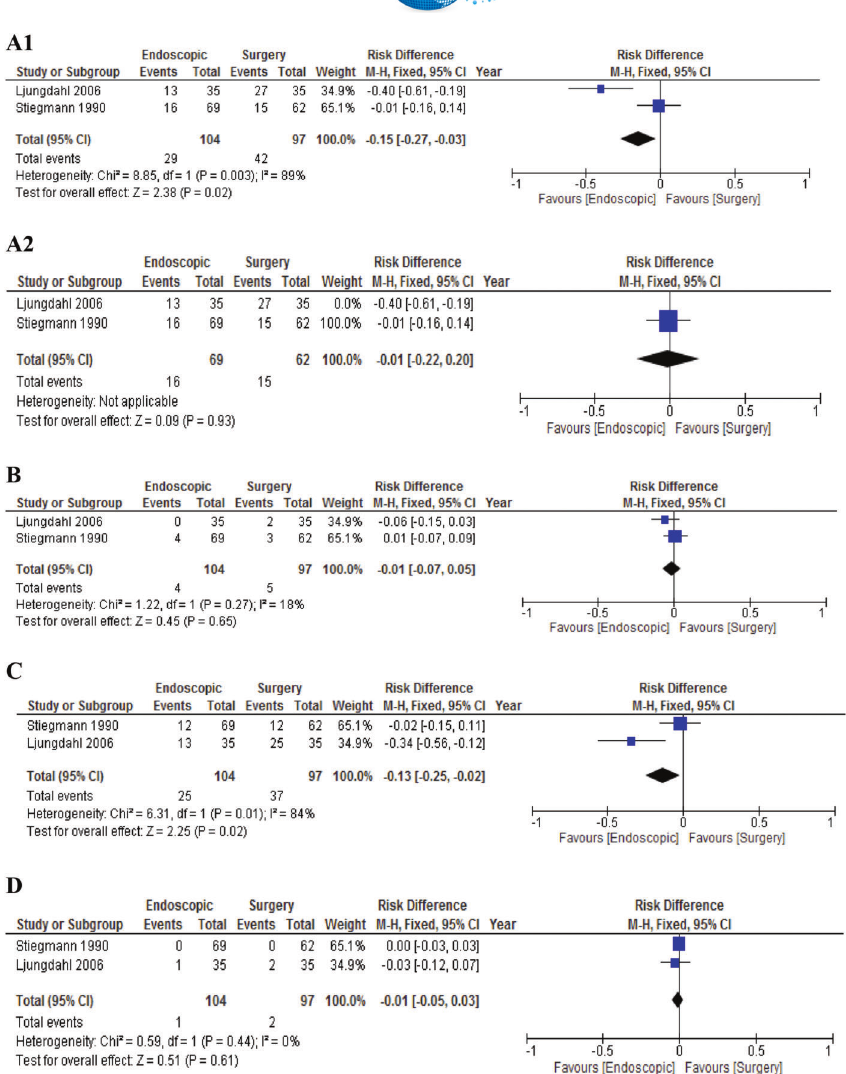
Figure 3 - Summary of meta-analysis of randomized studies. (A1-A2) meta-analysis of all complications for randomized trials. (B) meta- analysis of major complications in randomized studies. (C) meta-analysis of minor complications in randomized studies. (D) meta- analysis of mortality related to procedures in randomized studies.